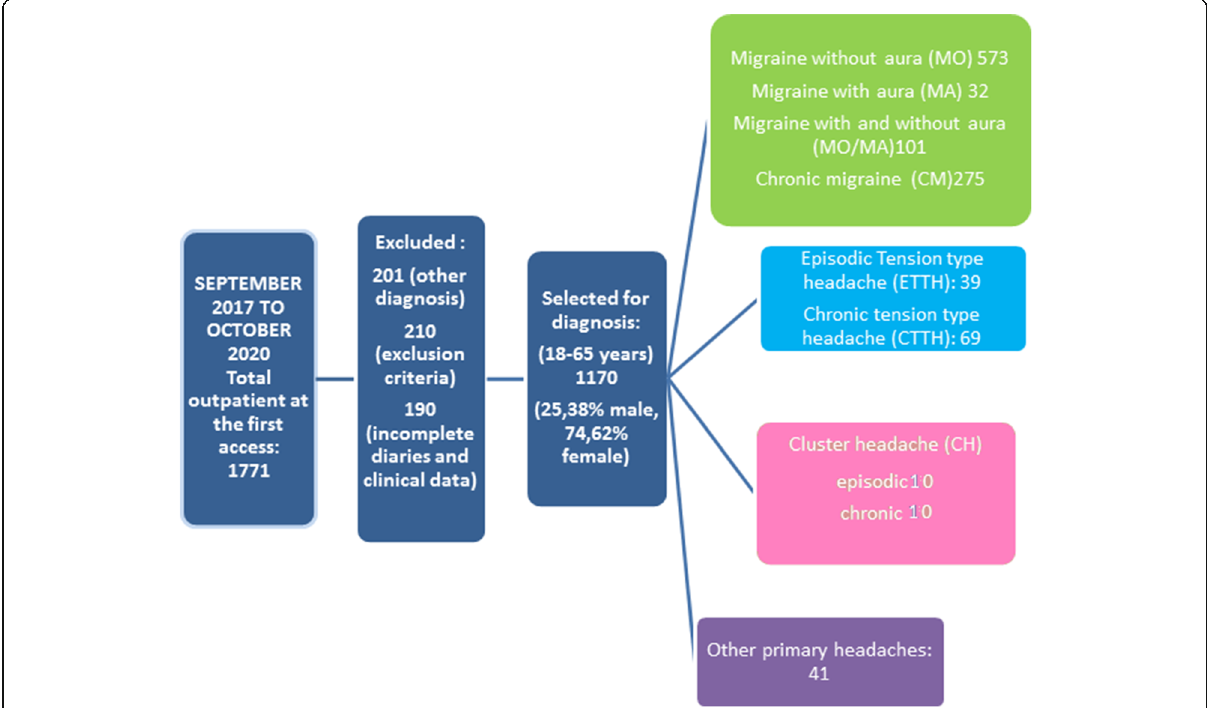
Fig. 1 Flow chart: patients ’